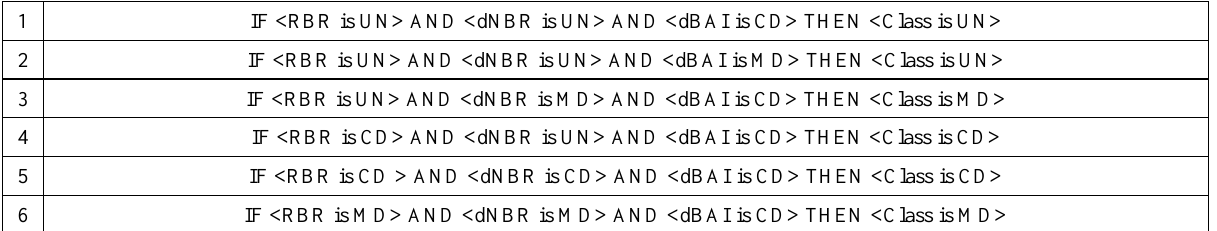
Table 4. Some rules applied in the FLS